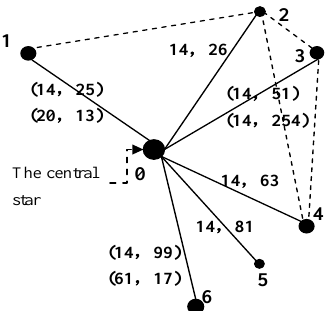
Figure.2. Central and Neighbouring Star identification.